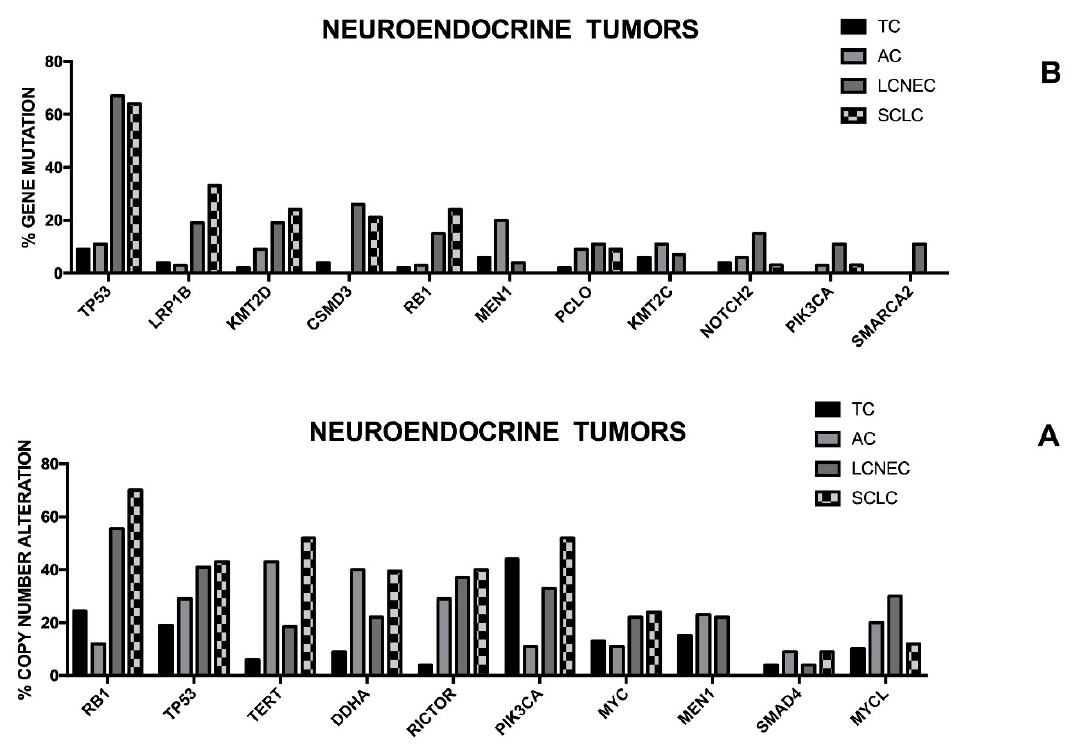
Figure 4. Genetic abnormalities observed in neuroendocrine lung cancers classified into four subtypes: TC (Typical Carcinoid); AC (Atypical Carcinoid); LCNEC (Large Cell Neuro Endocrine Carcinoma); SCLC (Small Cell Lung Carcinoma). A: Copy Number Alterations; B: Gene Mutations The data plotted in this figure were reported by Simbolo et al. [123].